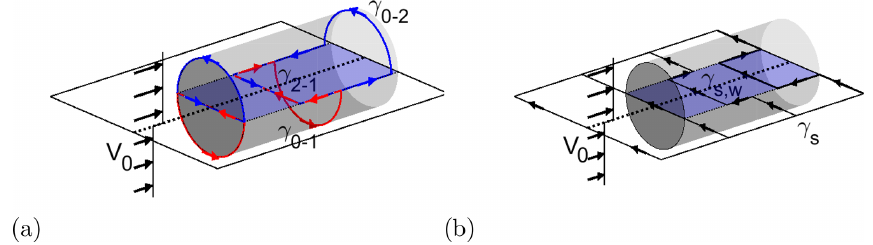
Figure 8. A 3D sketch of a non-uniformly loaded disc in a step shear with illustration of the deformation of wake and shear vorticity sheets: (a) deformation of wake vortex rings and (b) deformation of the vortex filaments which are responsible for the step